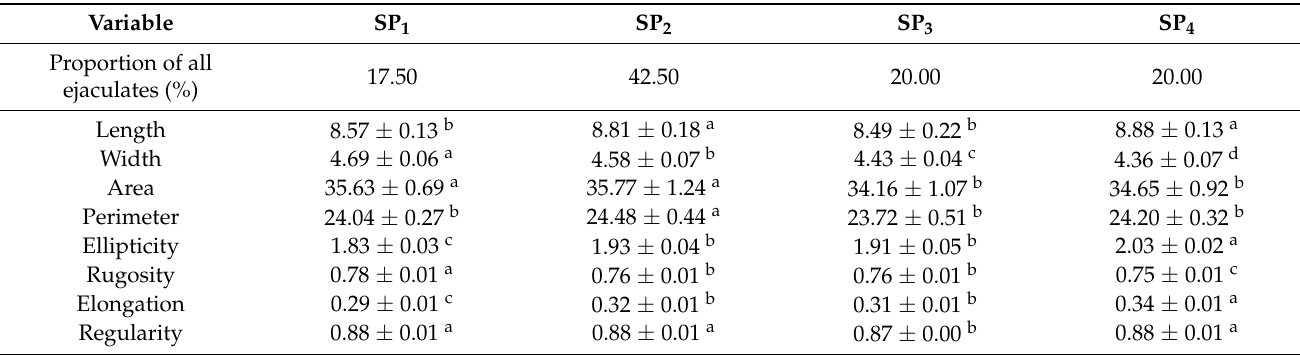
Table 4. Morphometry of sperm heads, head shape, and fertility variables (mean ± s.d.) of the four ejaculate sub-populations (SPs) defined from boar semen samples.